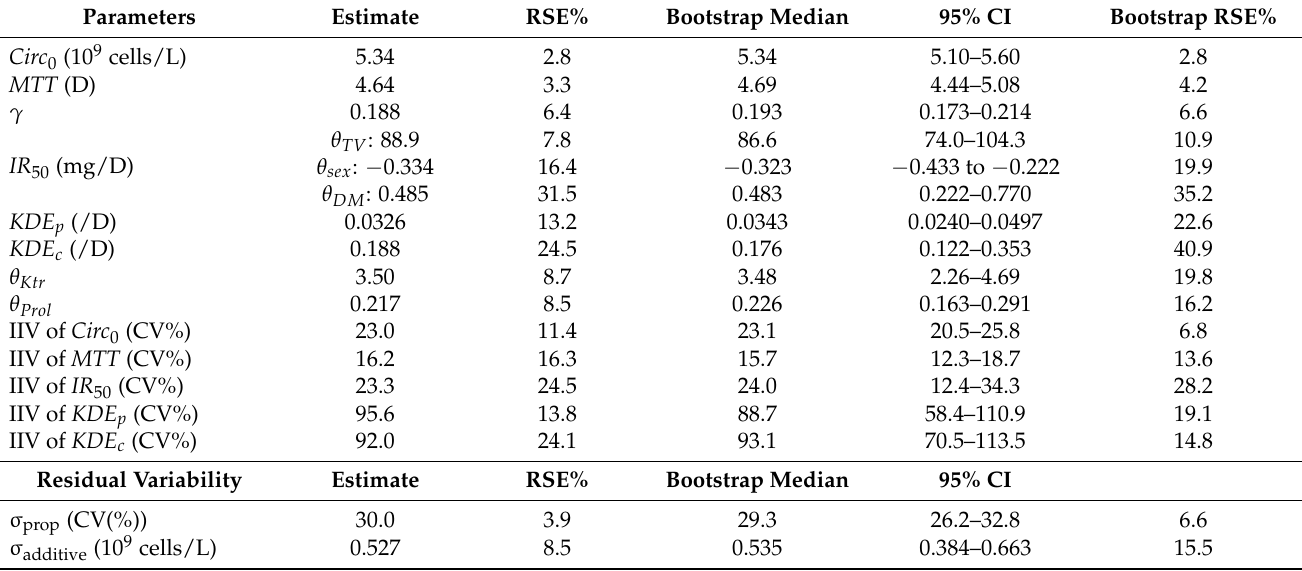
Table 2. Parameter estimates of the final